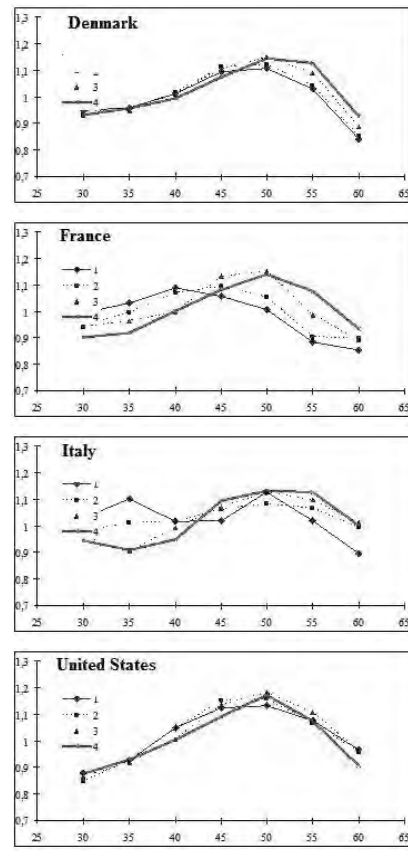
Figure 3: Relative Adjusted Disposable In- come (RADI) by Age Group for Th ree Pe- riods 19 Th e main results of the comparison of the re- lative adjusted disposable income (RADI, fi- gure 3)